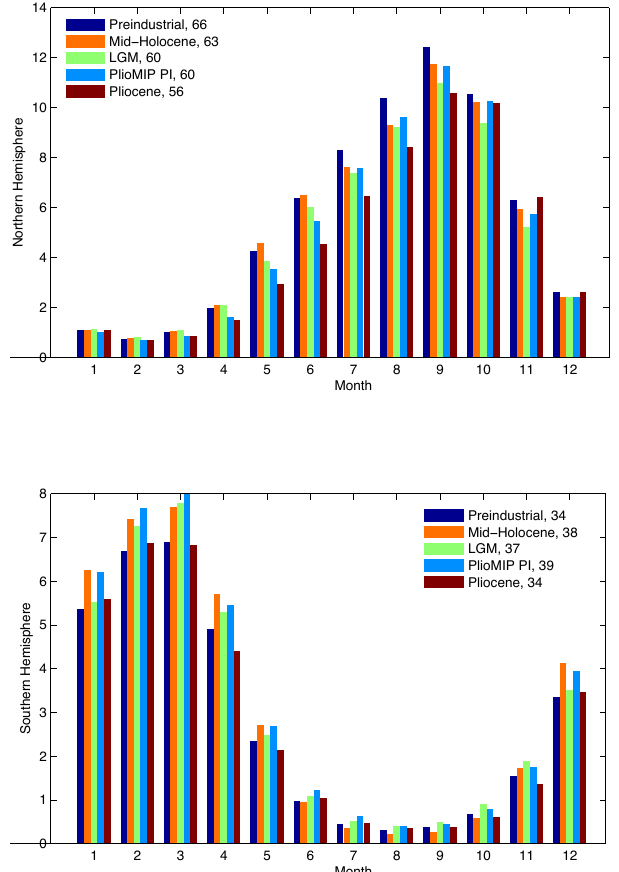
Figure 10. Ensemble monthly cumulative genesis potential index for the different time periods over (a) the Northern Hemisphere and (b) the Southern